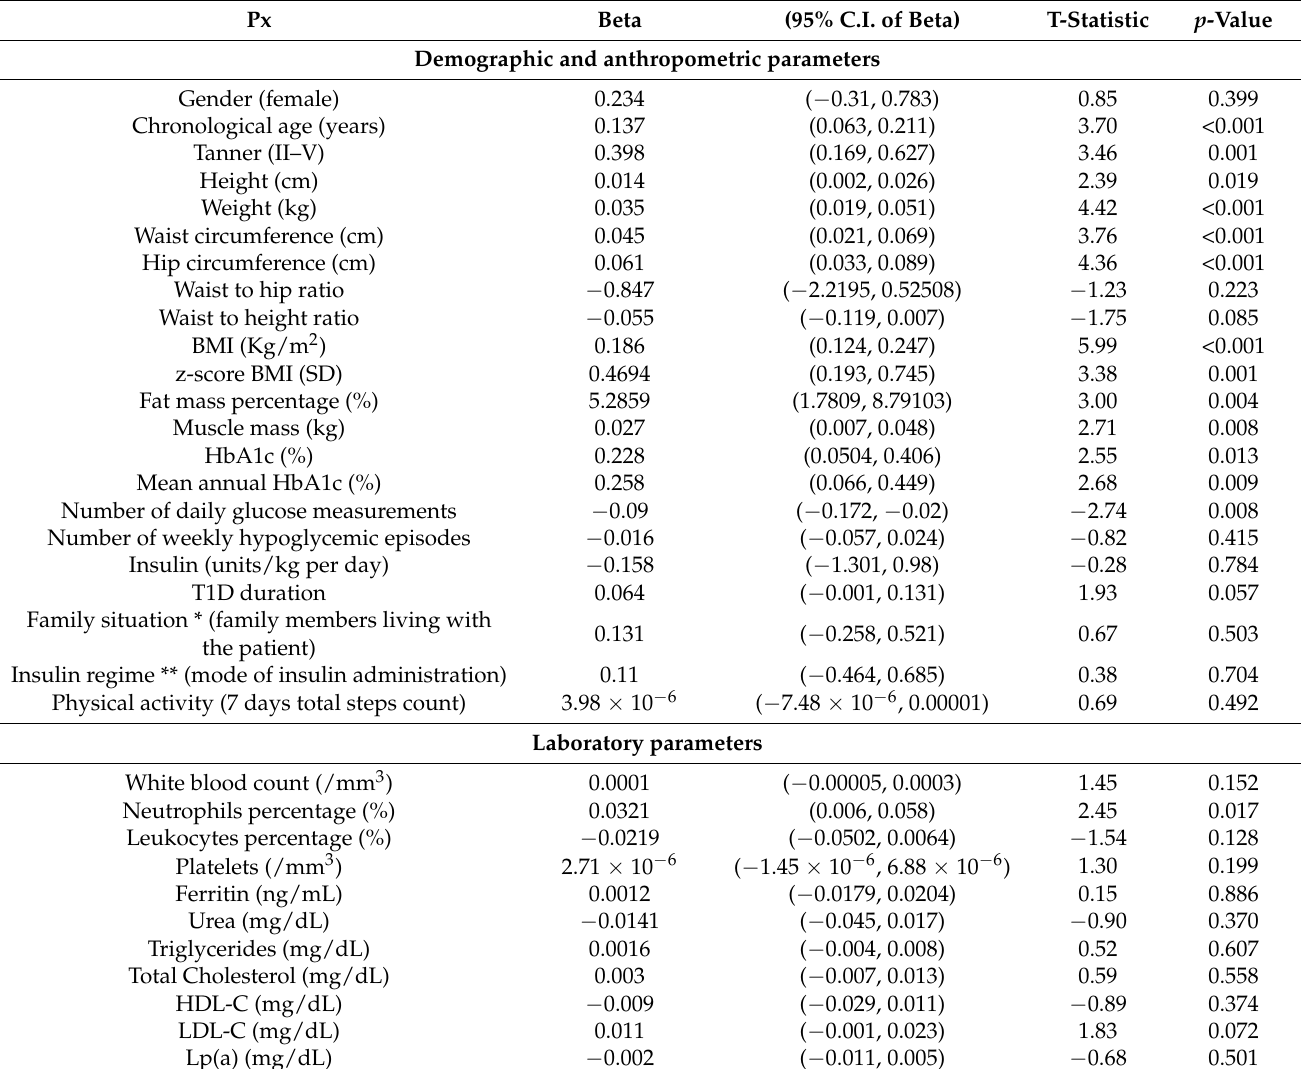
Table 5. hs-CRP correlations with basic demographic and physical and biochemical parameters with the use of univariant linear